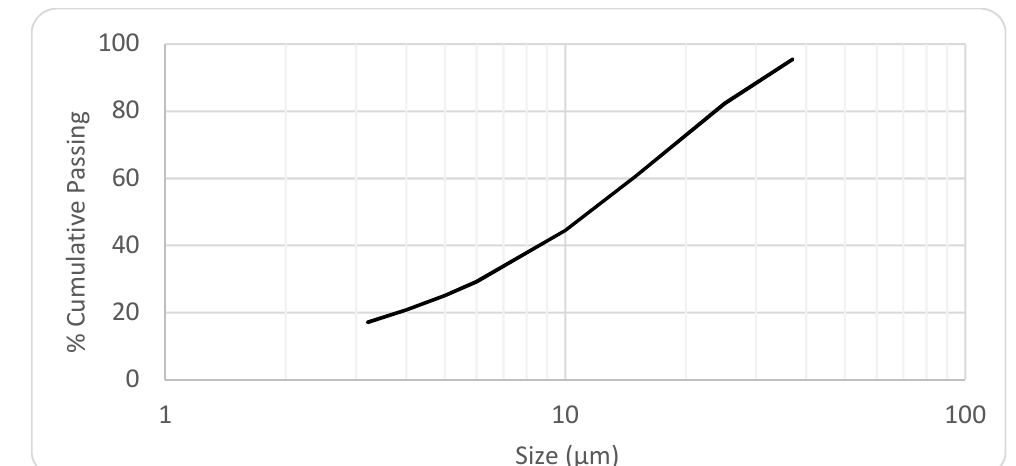
Figure 1. Particle size distribution of the iron ore slime (sample 1).